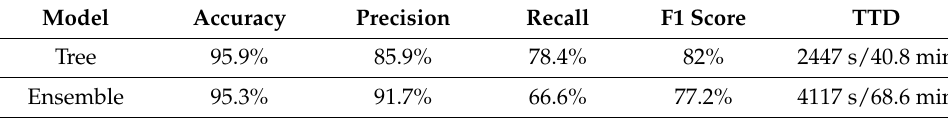
Table 2. Baseline model results.